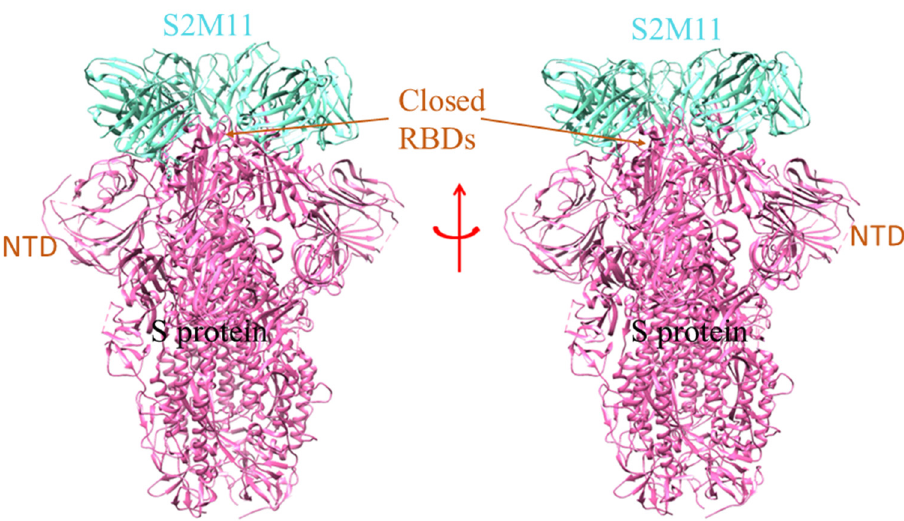
Figure 4. The model shows the human nAb (S2M11) binding with the adjacent part of RBD in closed conformation of S-protein [PDB id: 7K43]. The different domain of SARS-CoV-2 S-protein is marked, where the RBD region interacts with the single unit of nAb (S2M11).